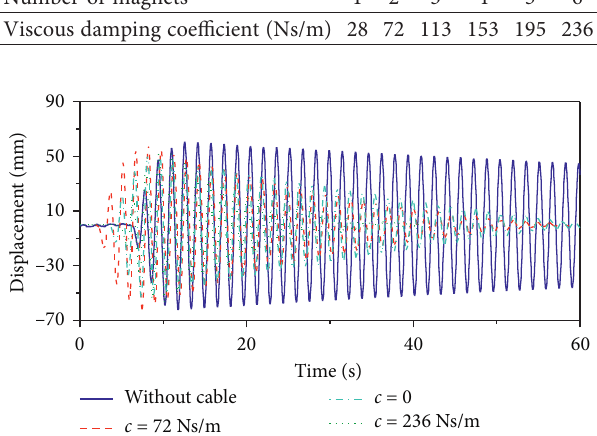
Figure 3: The time history curve of the system with different damping coefficients c .